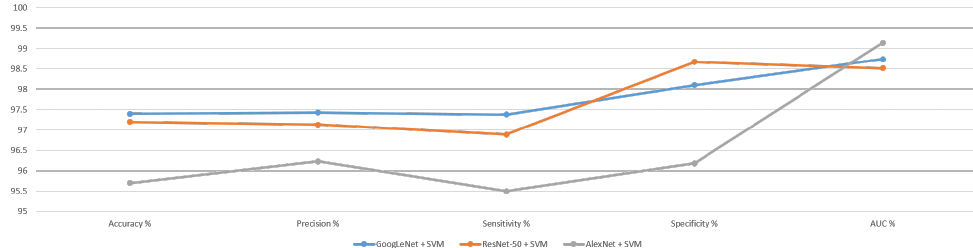
Figure 11. Performance of hybrid technique for diagnosing the hemorrhage